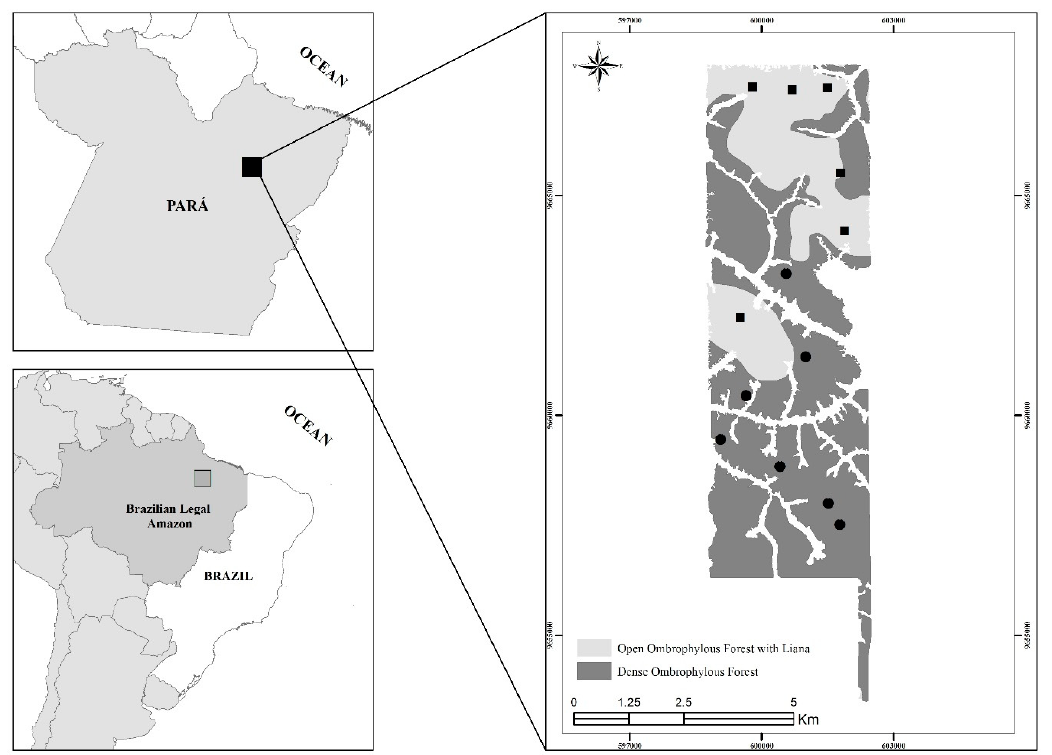
Figure 1. Localization of the Uberlandia Unit forest management area show the principal phytophys- iognomies: ombrophilous dense and open forest. The dots in the figure on the right represent plots in ombrophilous dense (circle) and open forest (square).